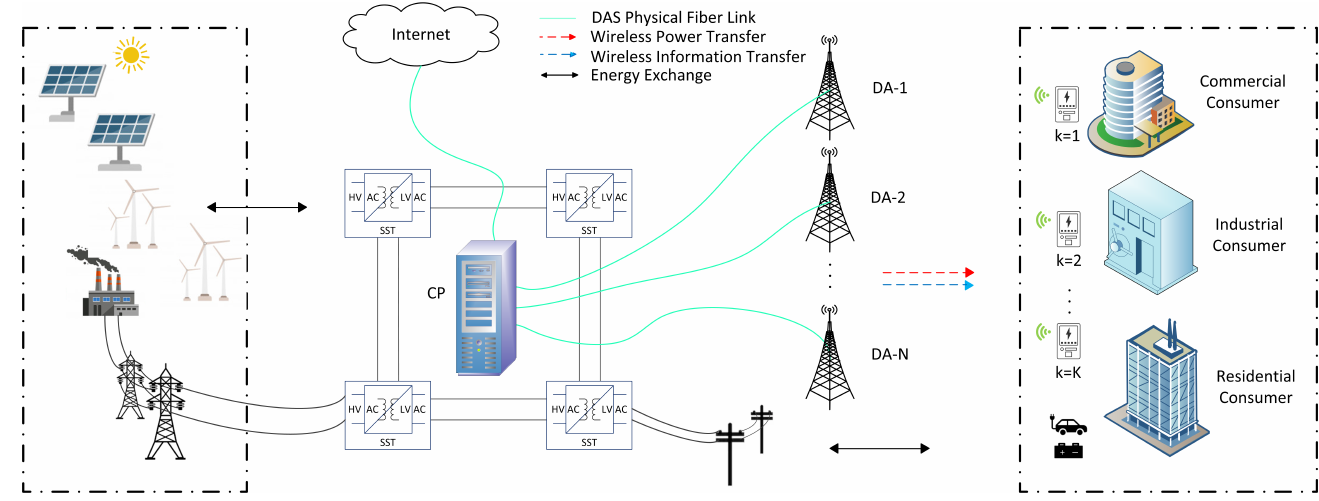
Figure 1. Structure of OFDM-DAS based IoT enabled PS-SWIPT in smart grid communication network.